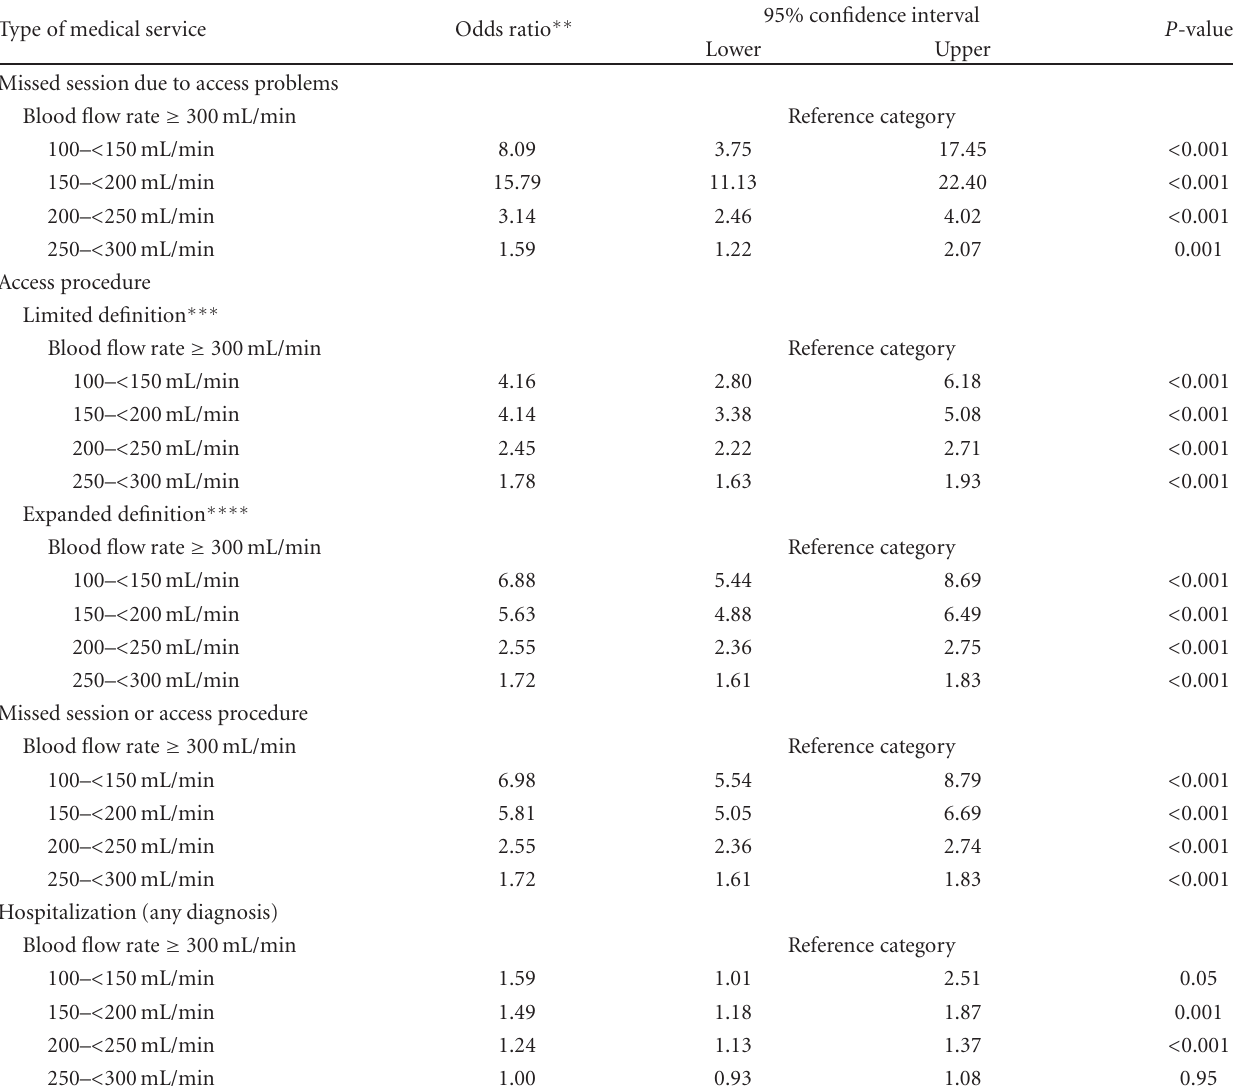
Table 4: Alternative specification of catheter dysfunction variable in repeated measures analysis ∗ of medical